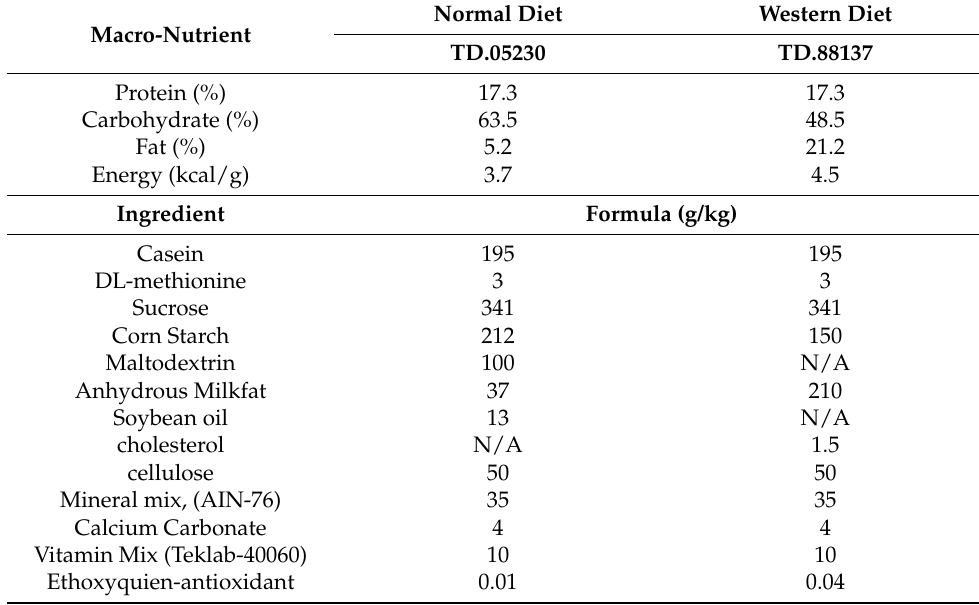
Table 2. Proximal composition (wet basis) and formulation of experimental diets.